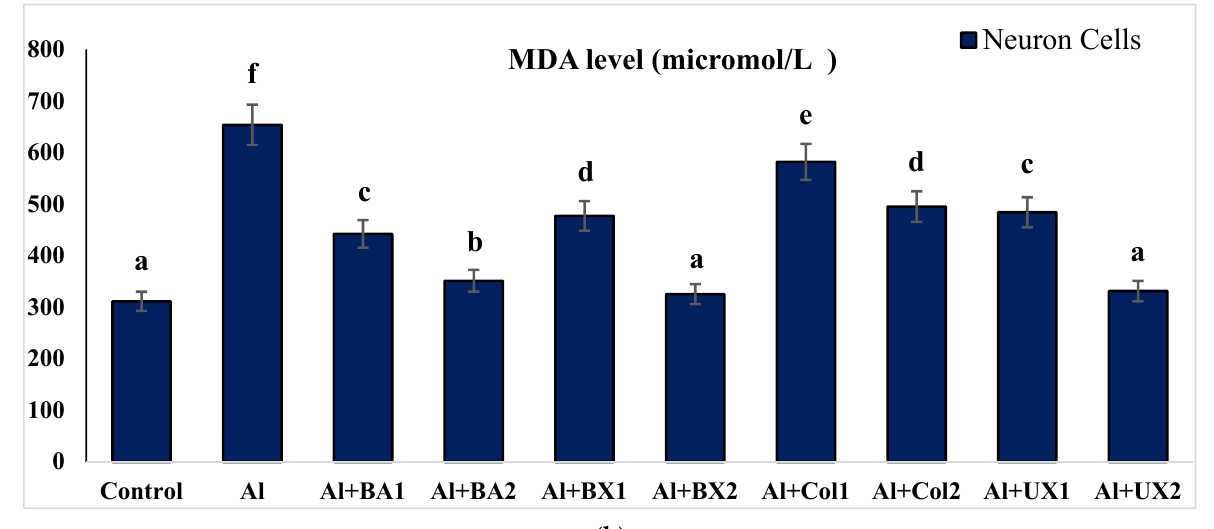
Figure 7. The effect of Al and boron treatments in ( a ) human blood and ( b ) PRCNs on MDA levels. Abbreviations are as in Figure 2. (Each superscript letter (a, b, c, d, e, f) represents statistically similar groups).